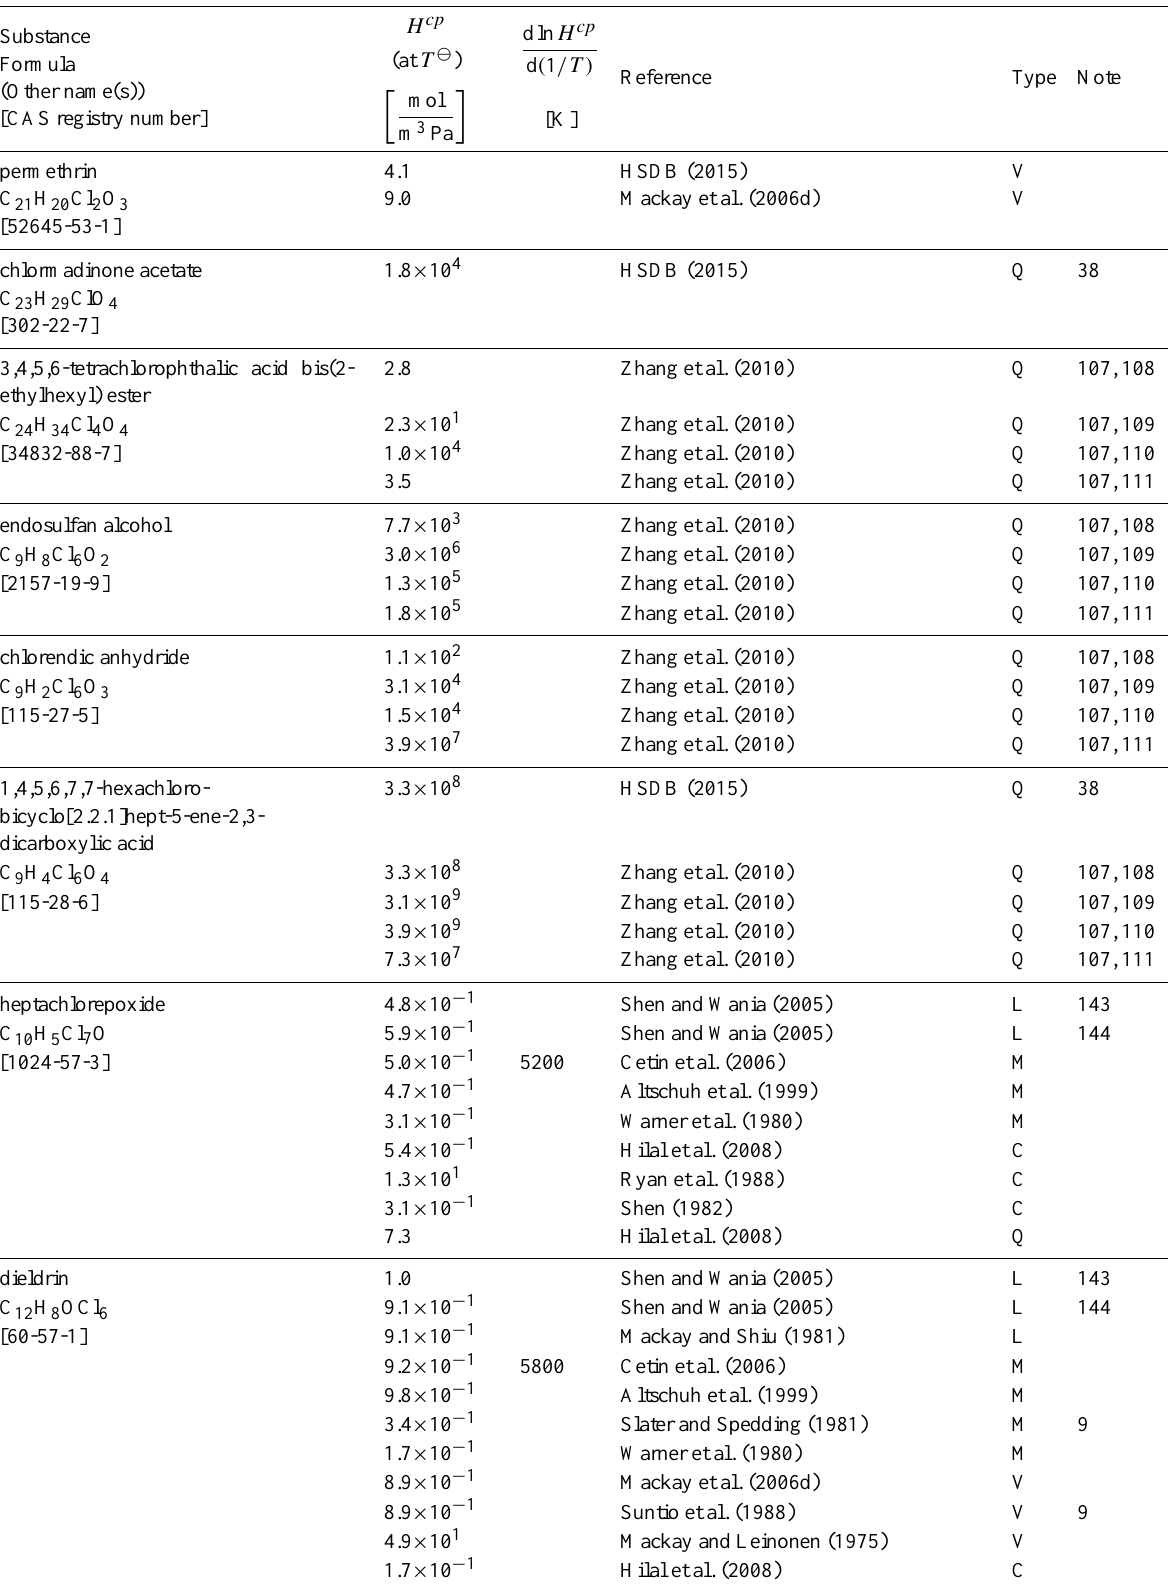
Table 6: Henry’s law constants for water as solvent